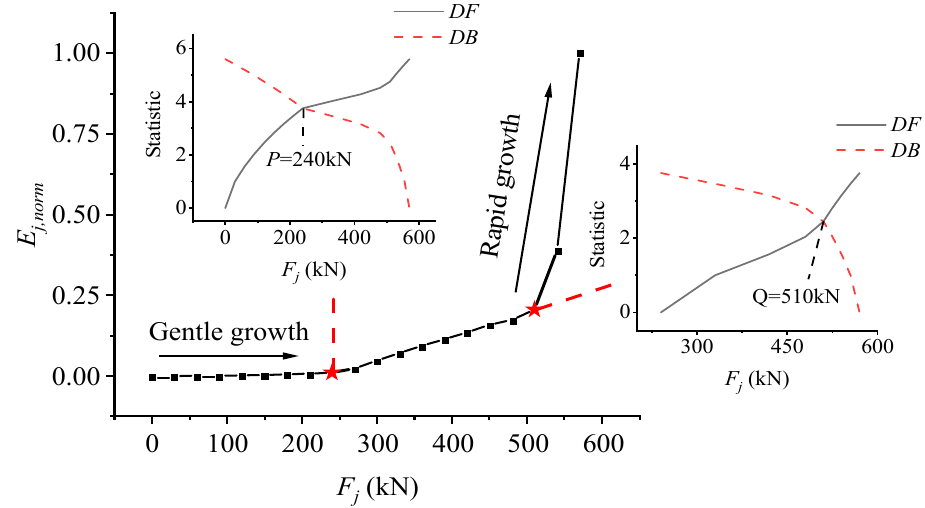
Figure 3. The E j , norm ‐ F j and M ‐ K statistic curves of the test beam.